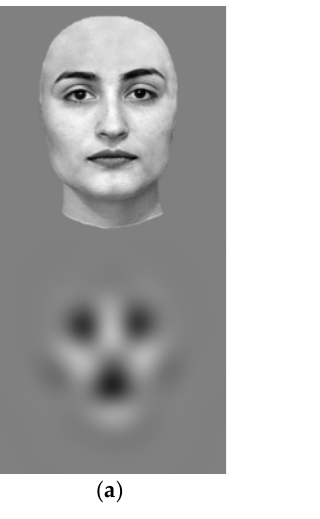
Figure 1. The upright ( a ) and inverted ( b ) face-like stimuli presented as peripheral targets ( bottom row ). Stimuli were obtained by filtering the upright and inverted faces used in [38] ( top row ) with a spatial frequency of 0.55